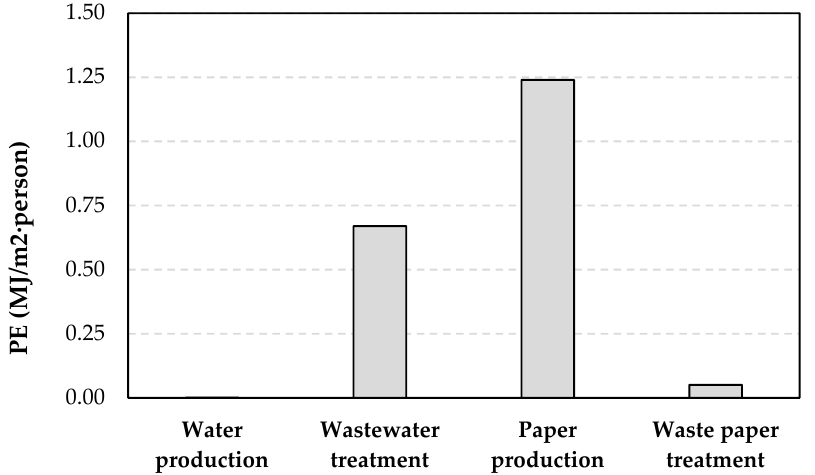
Figure 7. Contribution of the different flows to the total primary energy (PE).